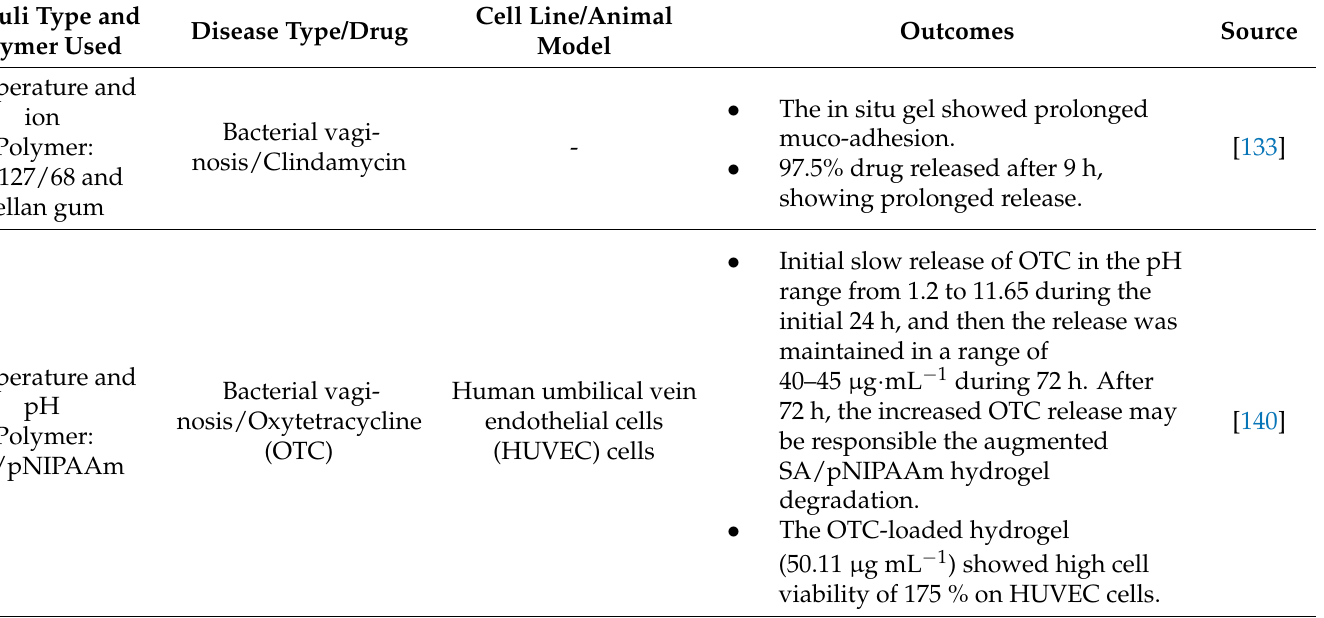
Table 6. Multi-stimuli responsive systems for vaginal drug